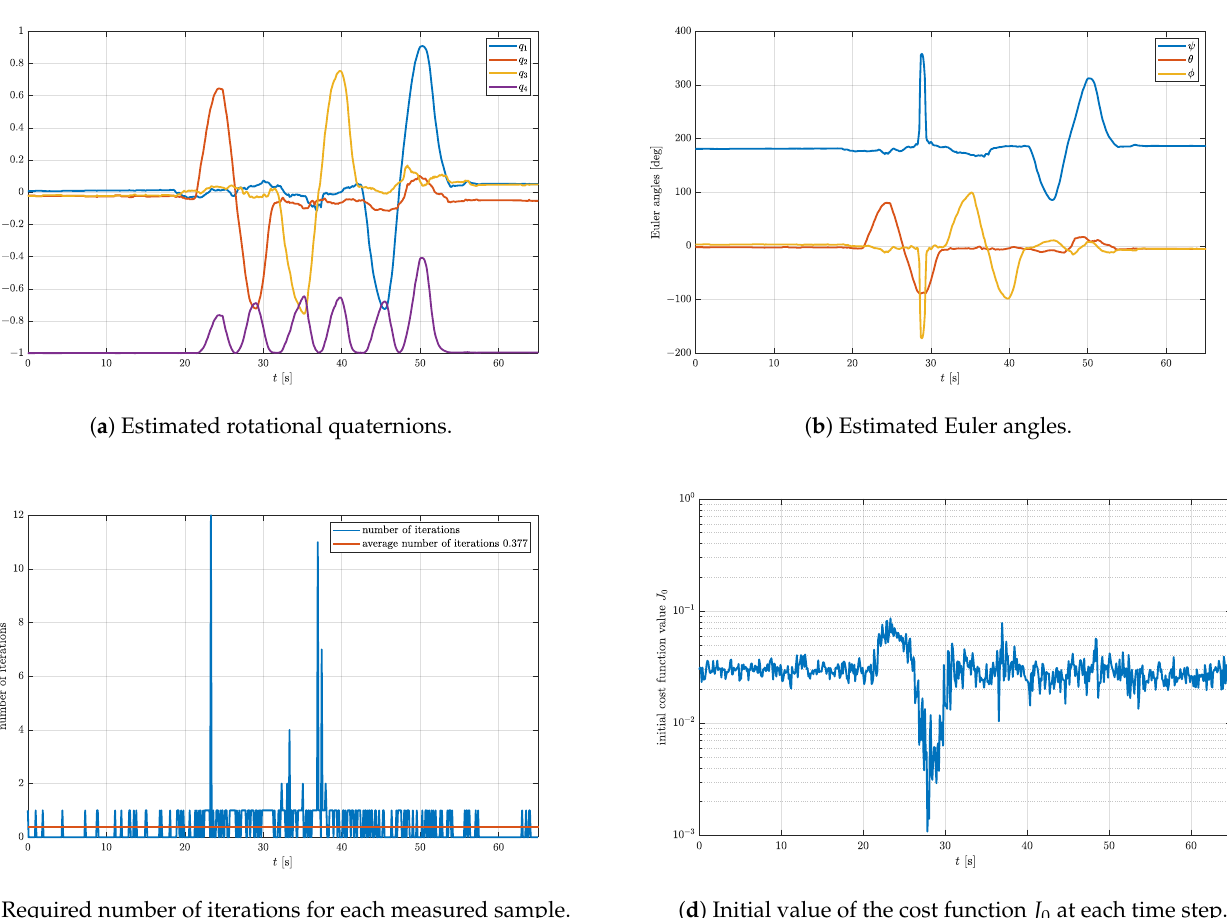
(cid:104) (cid:105) T , N max = 20, 0 0 0 1